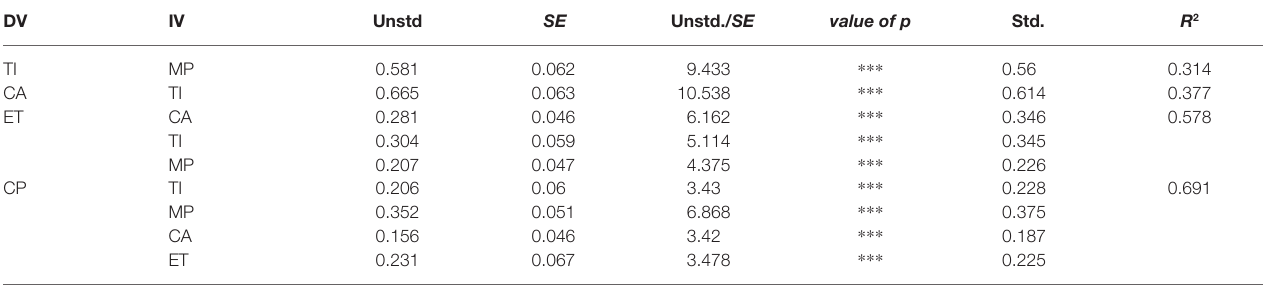
TABLE 5 | Regression coefficient.